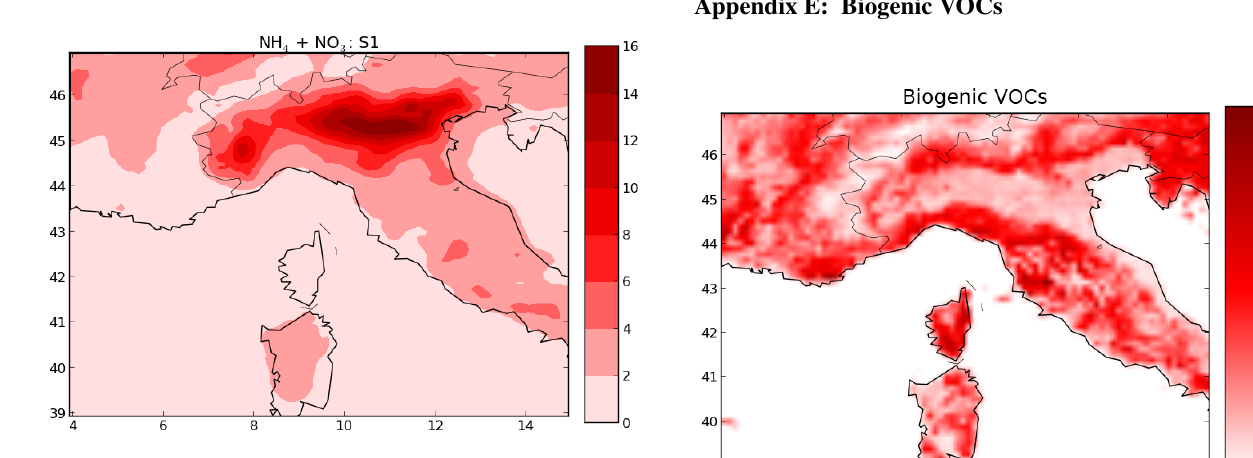
Figure D7. Map of the concentrations of NH 4 + NO 3 in PM 10 dur- ing the summer 2013.